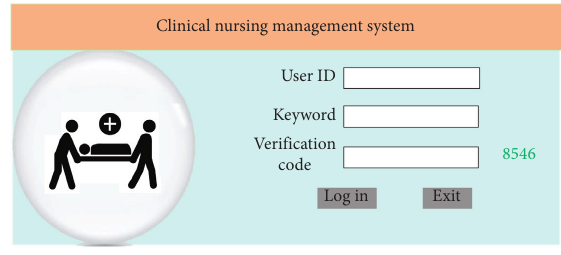
Figure 6: System login interface